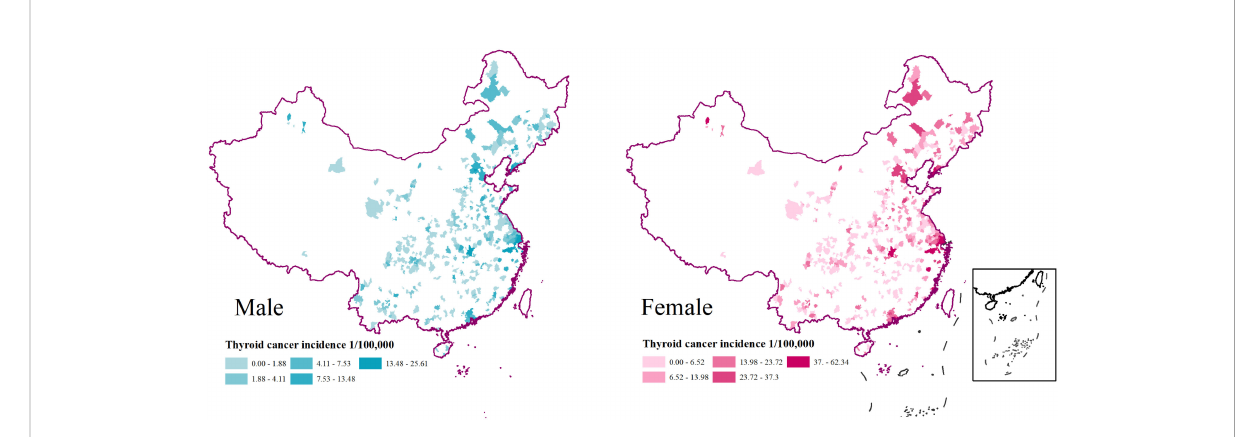
FIGURE 2 Spatial distributions of 487 registries and TC incidence by sex in China,